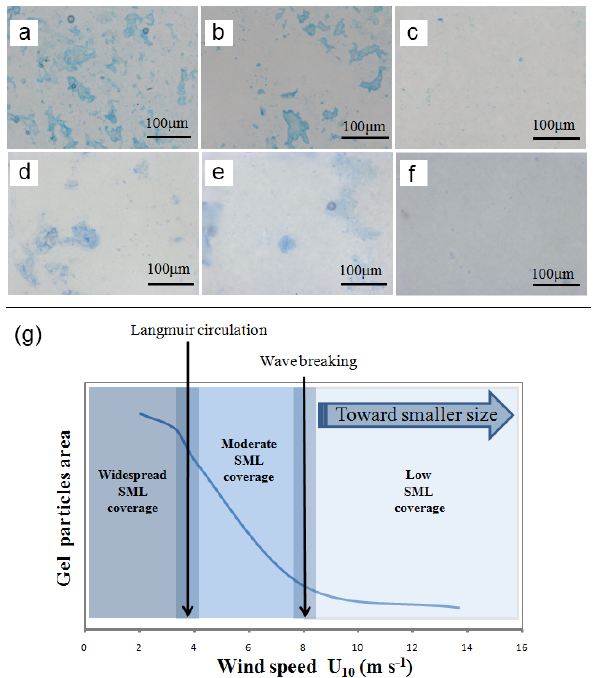
Figure 8. Strong accumulation of TEP and CSP in the SML at low wind speed as determined by microscopy, (a) TEP (2.0ms − 1 ), (b) TEP (4.3ms − 1 ), (c) TEP (8.3ms − 1 ), (d) CSP (2.0ms − 1 ), (e) CSP (4.3ms − 1 ), (f) CSP (8.3ms − 1 ); (g) proposed schematic for interactions between wind speed and gel particle coverage in the